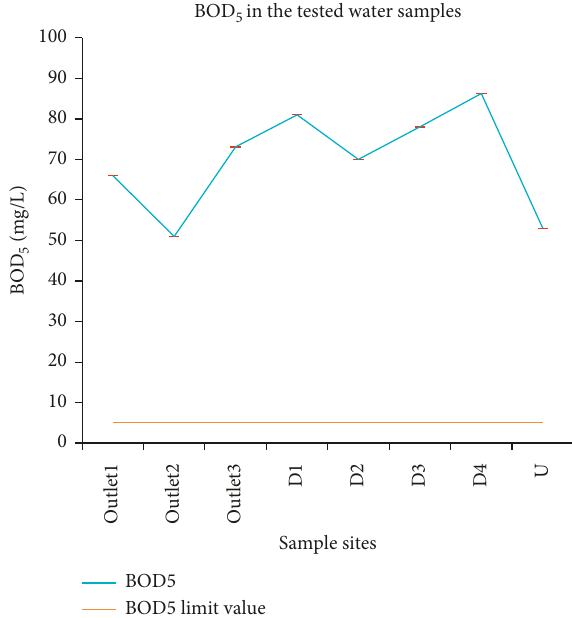
Figure 9: Comparison between the BOD 5 level in wastewater discharged from the Zenzelma campus and EPA recommended limit of BOD 5 in wastewater to be reused for agricultural activity.